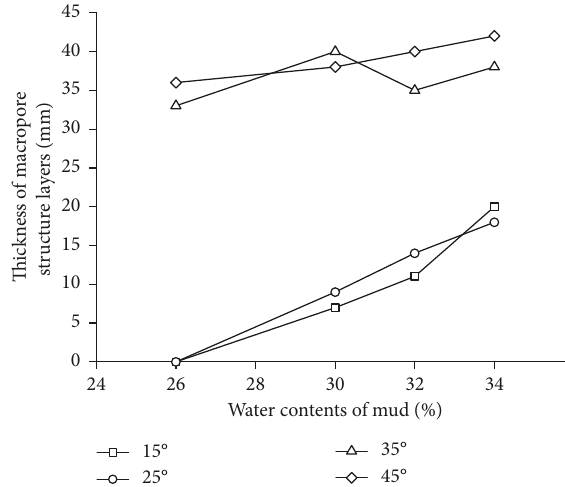
Figure 11: Thickness of macropore structure layers.